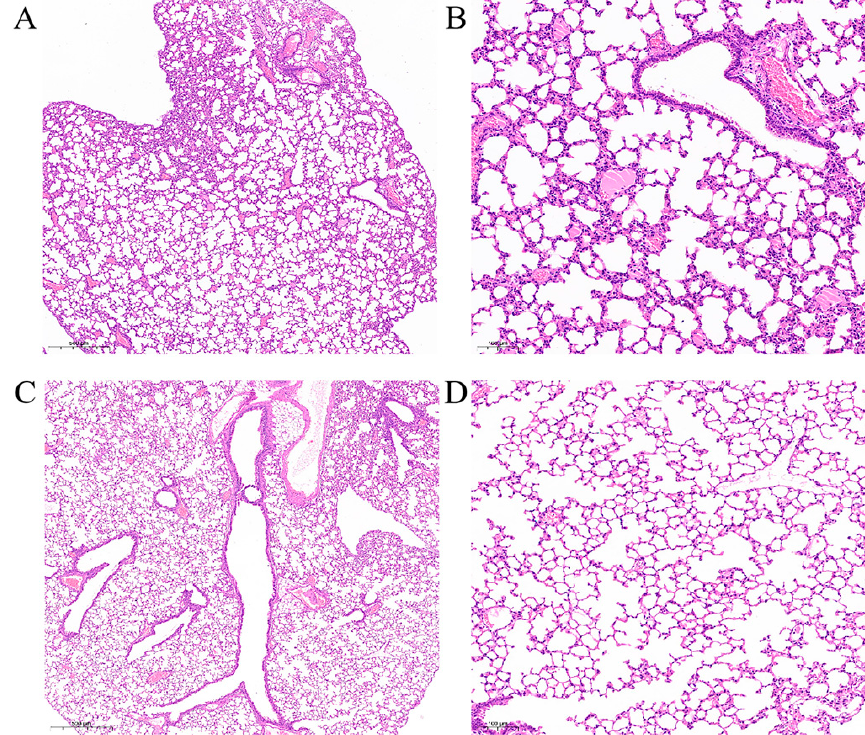
Figure 5. Mouse lungs histopathology with H&E staining. ( A ) Figure of lungs in challenge group, 3.0 × ; ( B ) figure of lungs in challenge group, 10.0 × . The cellulose exuded in a few alveolar, vascular congestion, and perivascular inflammatory edema occurred in challenge group lungs. ( C ) Figure of lungs in control group, 3.0 × ; ( D ) figure of lungs in control group, 10.0 × . Compared with challenge group, no obvious lesion could be examined in the lungs.